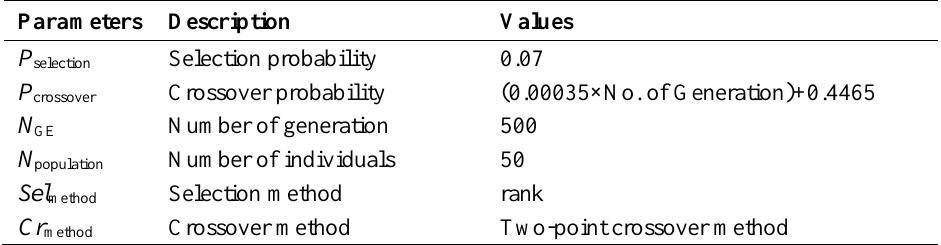
Table 3. Initial values for GA parameters.